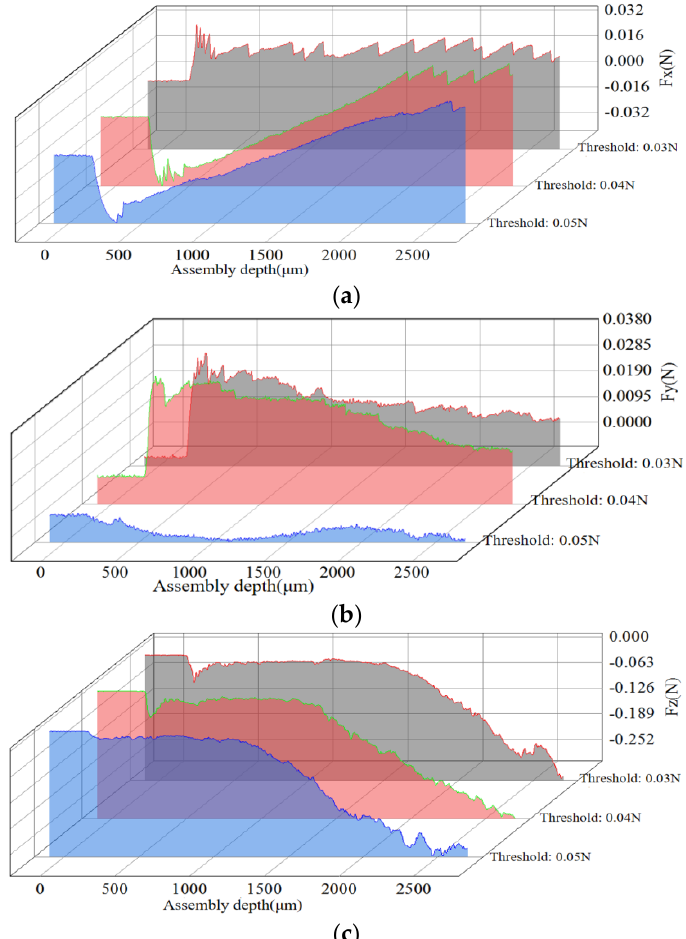
Figure 20. Comparison chart of the forced states with different force feedback thresholds. ( a ) Comparison of radial forces at different force feedback thresholds in the first assembly experiment; ( b ) Comparison of radial forces at different force feedback thresholds in the second assembly experiment; ( c ) Comparison of axial force at different force feedback